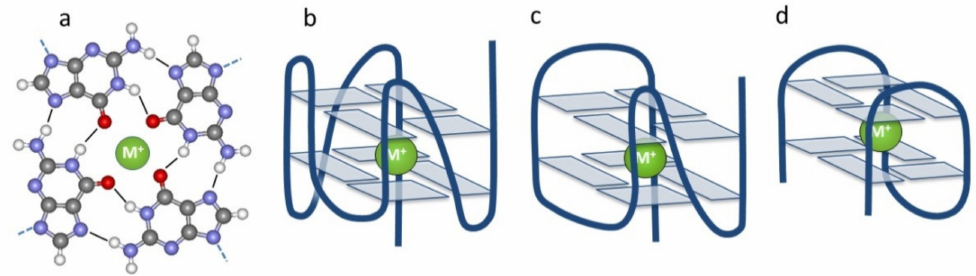
Figure 1. ( a ) Structure of a G-quartet formed by four guanine bases. The figure was made by the Viewerlite 4.2 program, selecting one quartet from the 2HY9 pdb structure. ( b – d ) Typical structures of a two-quartet GQ. The panels show the parallel, hybrid and basket forms